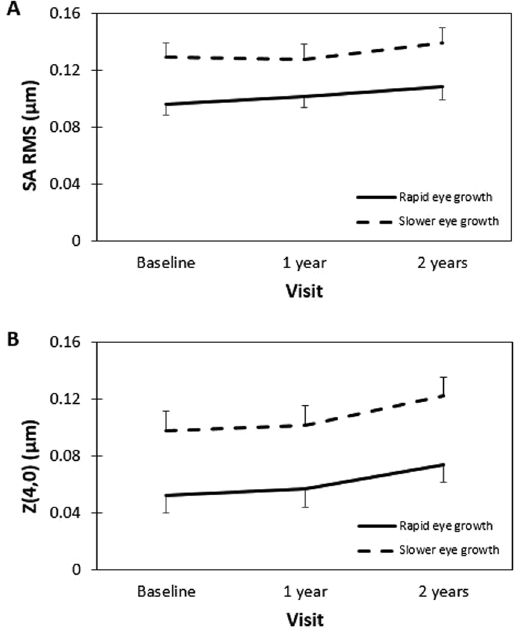
Figure 2. The change in unadjusted ( A ) SA RMS and ( B ) primary SA (Z ) 40 values over a 6 mm pupil diameter for subjects who exhibited rapid eye growth (solid, mean ± SD: 0.91 ± 0.23 mm) and slower eye growth (dashed, mean ± SD: 0.40 ± 0.15 mm) based on a median split of the axial elongation over two years (n = 64 in each group). Error bars represent the standard error. SA RMS: RMS of spherical-like aberrations ( Z 40 and Z 60 combined); SA: spherical